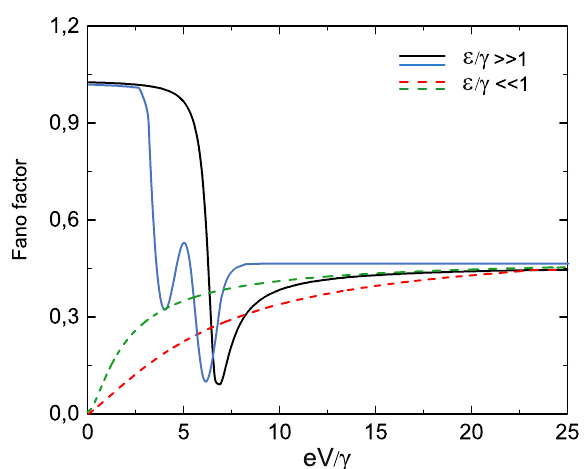
0 a and − 1 and ε/γ 1 for the T 0 a channel. The limiting case − ≫ ≪ a channel and blue line depicts results − 1 is depicted by the dashed curves (black ≪ 0 channel). S − −